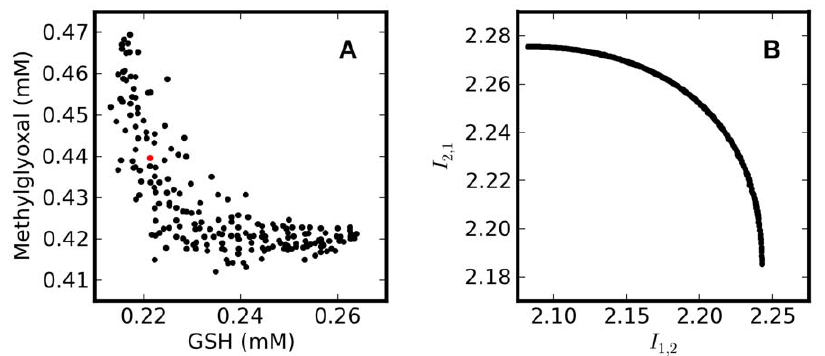
Figure 4. Optimization of experimental design for model discrimination. A - Optimal initial concentrations of methylglyoxal and glutathione (solutions approximating the Pareto front) for the discrimination of the two models presented in figure 2. B – Corresponding values of the extended Kullback-Leibler distances (optimization objectives); Concentration of glyoxalase I is 2.0 6 10 2 3 mM and concentration of glyoxalase II is 4.0 6 10 2 4 mM. The red dot indicates the initial concentrations used in the discriminatory experiment.